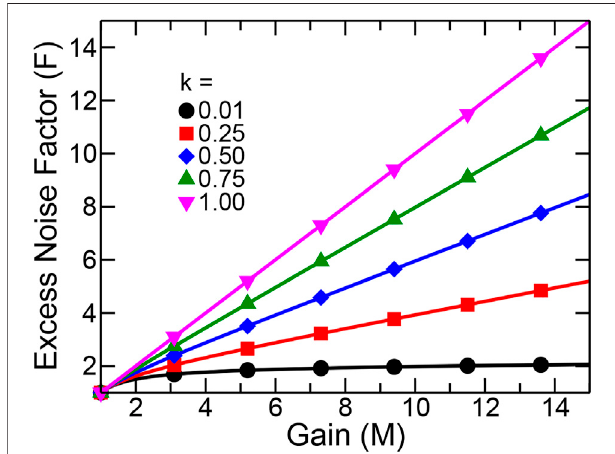
FIGURE 3 | Excess noise factor as a function of the gain from the local model ( Eq. 2 ) for k = 0.01, 0.25, 0.5, 0.75, 1.